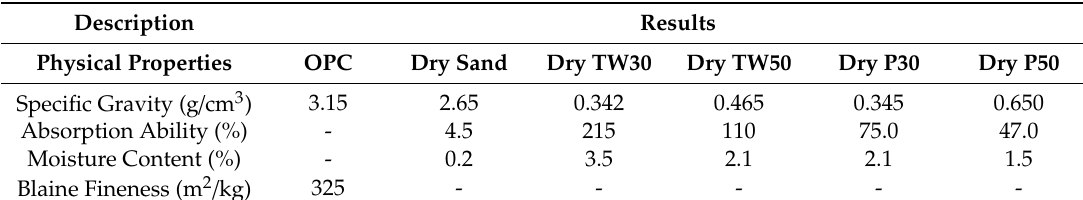
Table 1. Physical properties of sand, tea waste, and perlite particles. OPC, ordinary Portland cement; TW, tea waste; P, perlite. TW, tea waste; P, perlite.